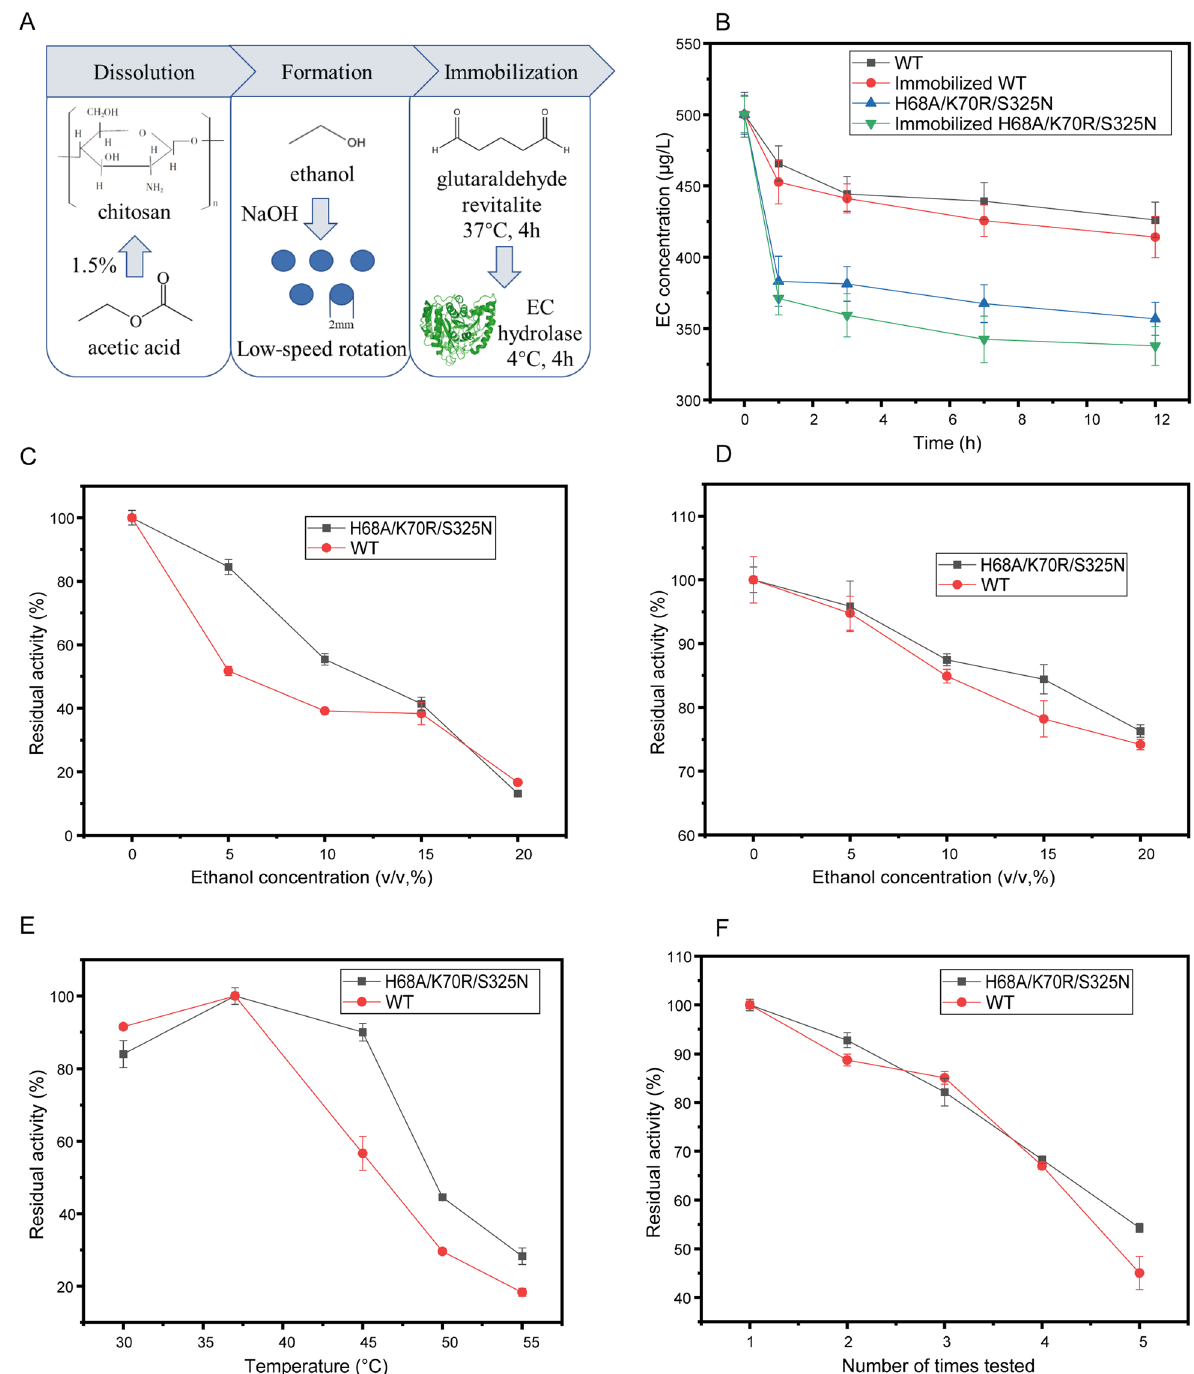
Fig. 5 Determination and application of enzymatic properties after immobilization of EC hydrolase. A Enzyme immobilization B Application of WT and mutants in simulated wine samples C Ethanol stability of immobilized enzyme D Ethanol tolerance of immobilized enzymes E Optimum temperature for immobilized enzyme F Reuse of immobilized